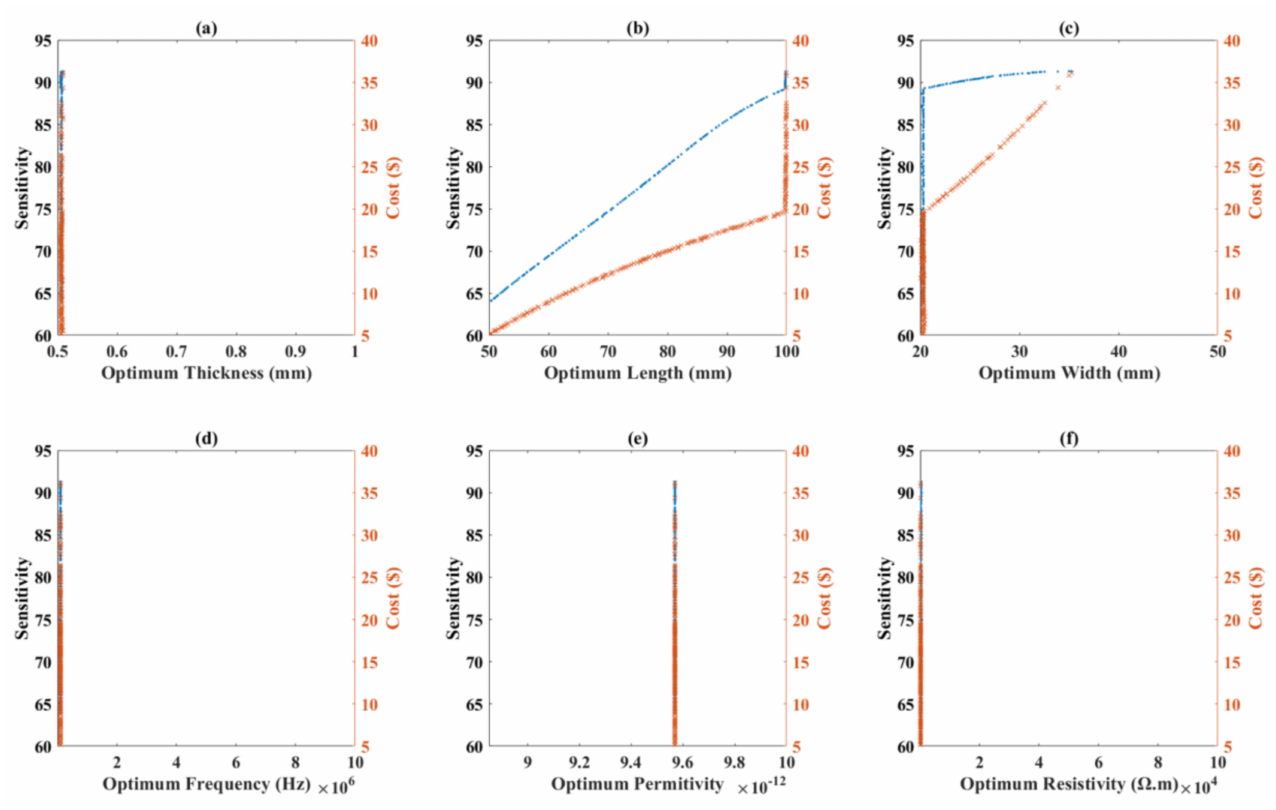
Figure 10. ( a – f ) Scatter of distribution for different design parameters versus objective functions as a result of optimization for a sensor with 1.25% wt.